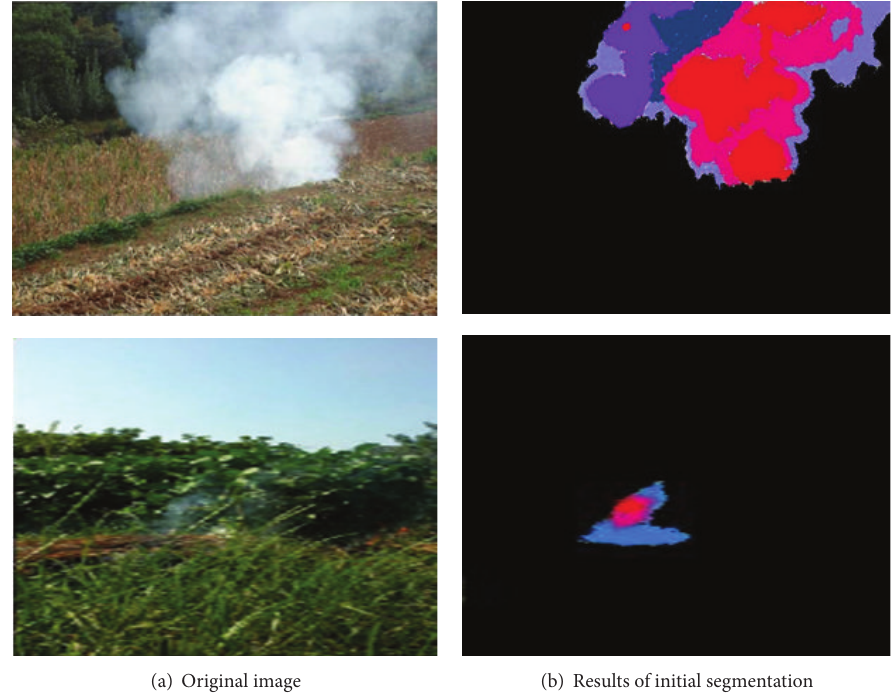
Figure 3: The results of initial segmentation ((a) and (b) show original image and the results of initial segmentation,